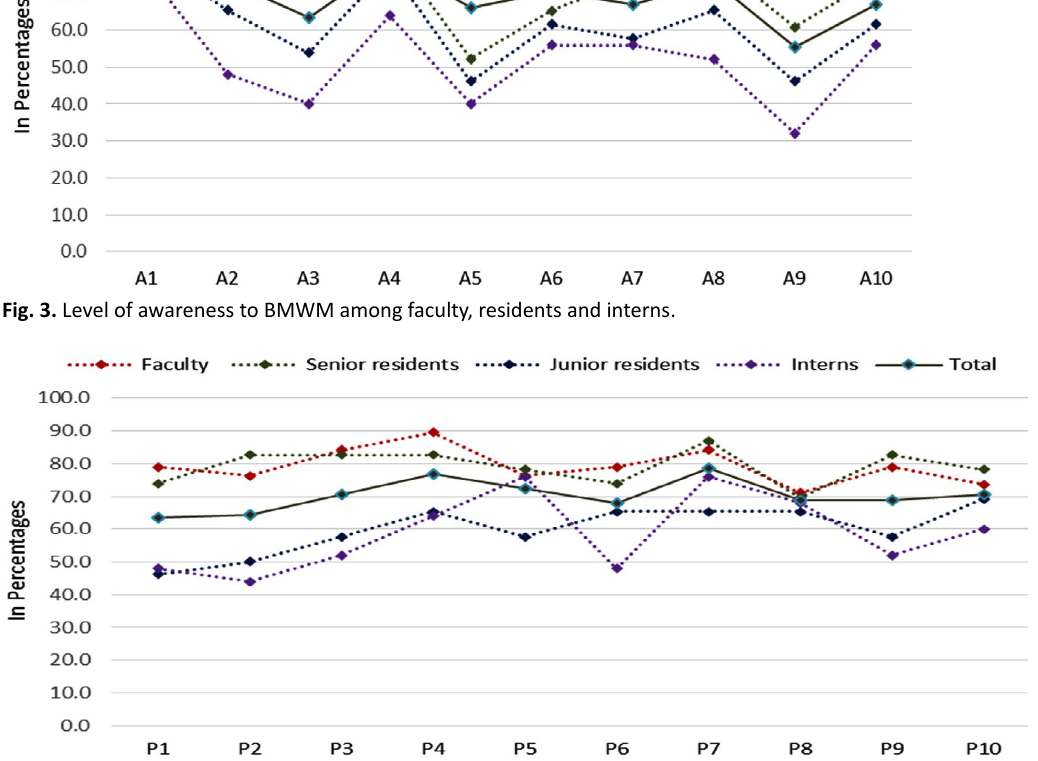
Fig. 4. Level of practices to BMW among faculty, residents and